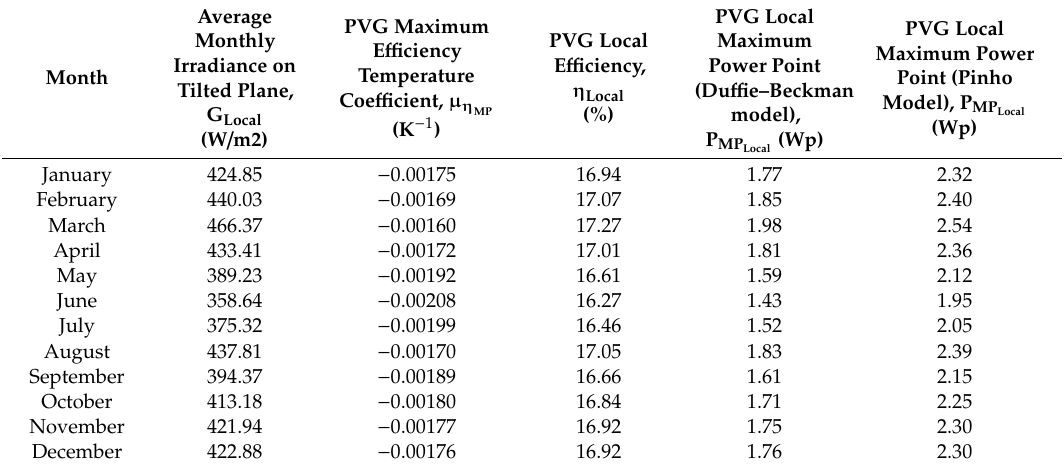
Table 3. Photovoltaic generators (PVG) power yield at local operating conditions.